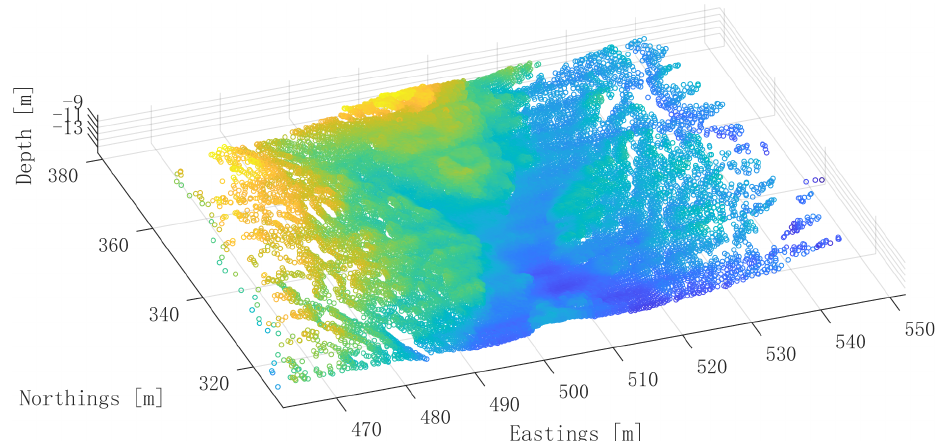
Figure 3. A 3D point cloud bathymetry map acquired by an AUV, used as a test map in the rest of the